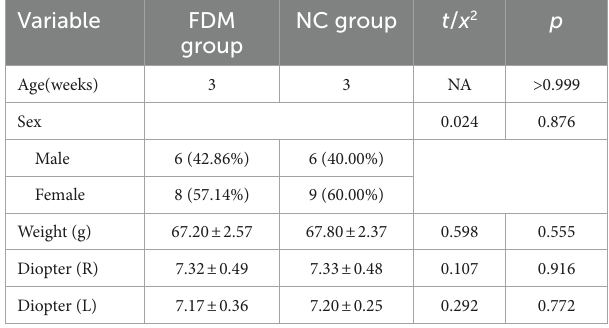
TABLE 1 The baseline of characteristics of rats in the study.